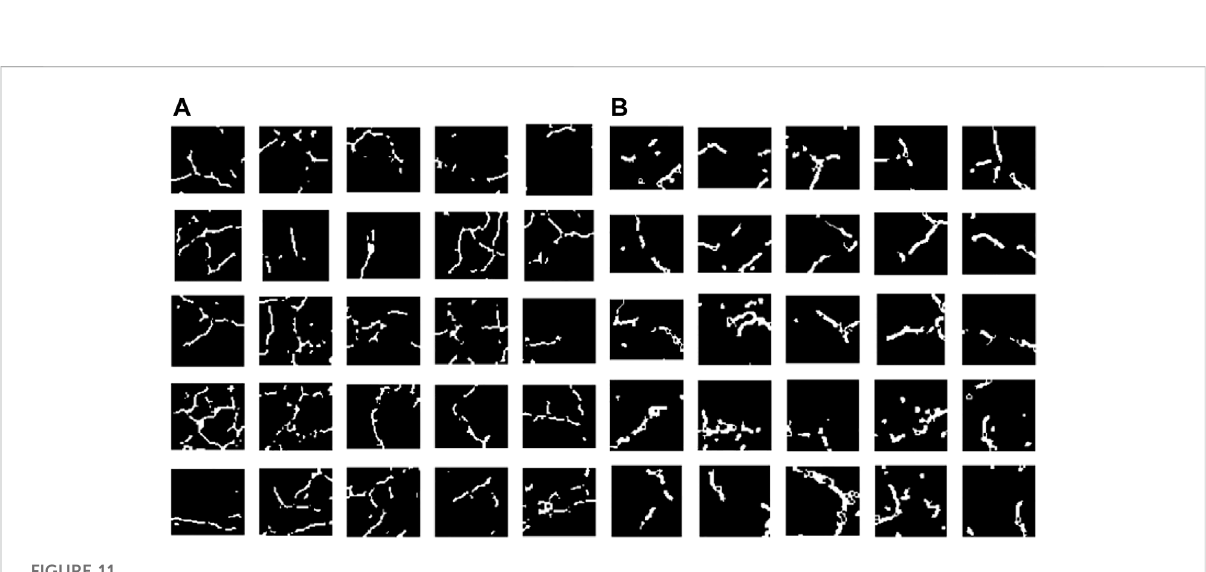
FIGURE 11 Results of binarization. (A) Crack. (B) Free